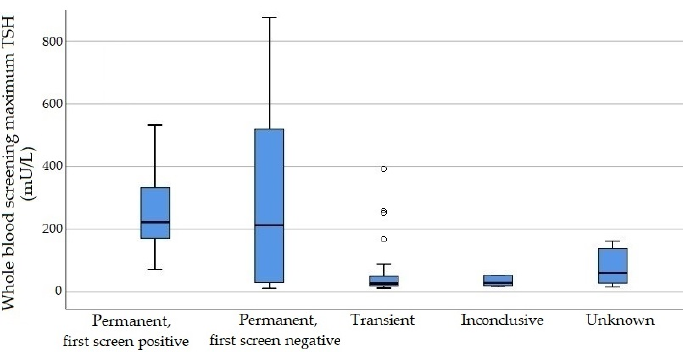
Figure 2. Maximum TSH screening values (whole blood, mU/L). Boxes represent median and interquartile range (IQR). Whiskers range between the minimum and maximum values, excluding outliers >1.5 IQR from the box which are represented by small circles.